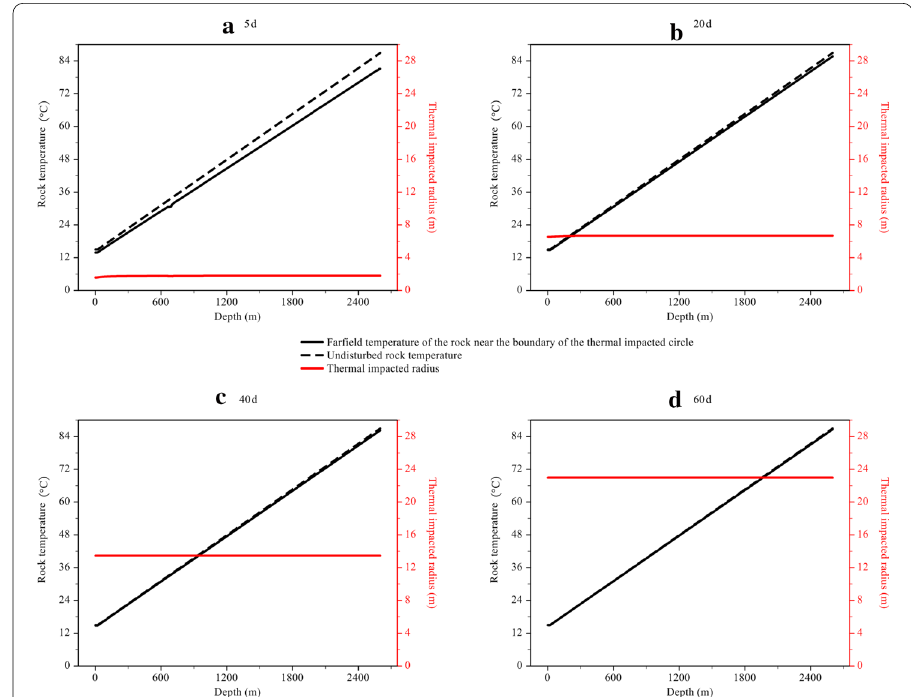
Fig. 14 Variation of thermal impacted radius and rock temperature near the boundary of thermal impacted radius (radial far field temperature of rock) on the basis of efficient modeling along depth with time during the heating season. a 5 days, b 20 days, c 40 days, d 60 days. The black and black dotted line denoting rock temperature refer to the left y -axis, while the red line denoting thermal impacted radius refers to the